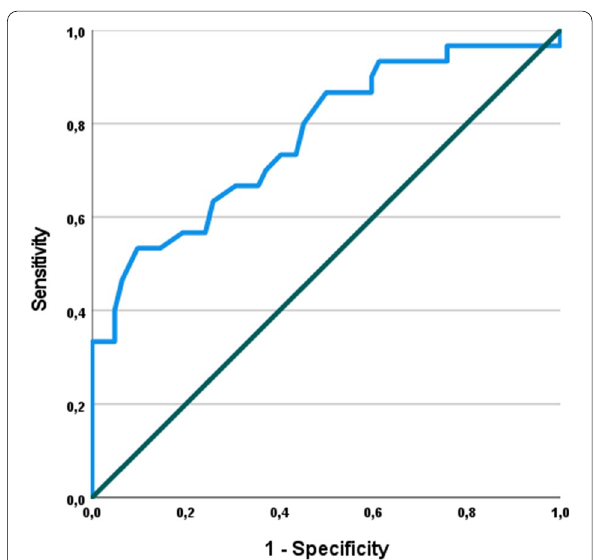
Fig. 1 Receiver operating characteristics curve for synovial